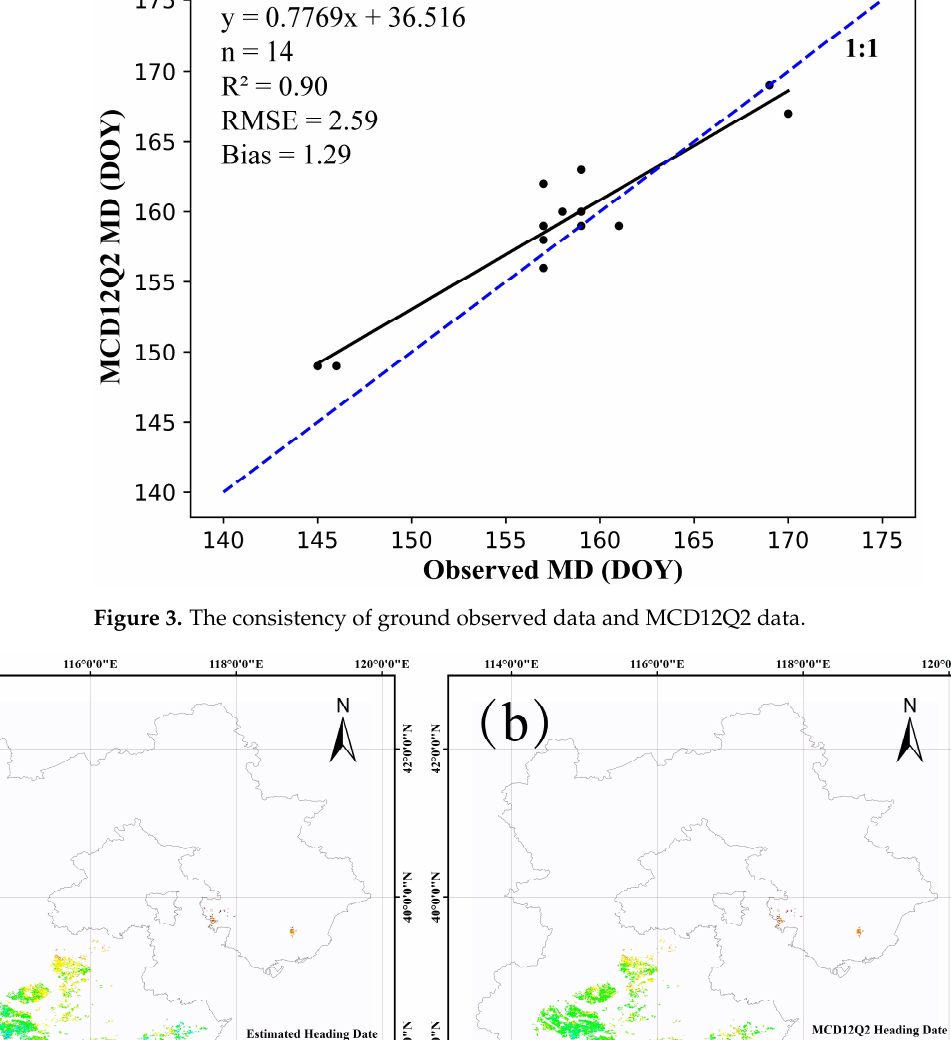
Figure 3. The consistency of ground observed data and MCD12Q2 data.